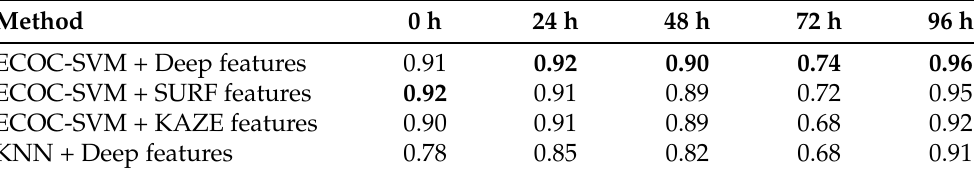
Table 3. The accuracy results against incubation time for the best four methods on the test data set. The incubation period starts from 0 h with increments of 24 h until 96 h. Accuracy values range from 0 to 1 inclusive.